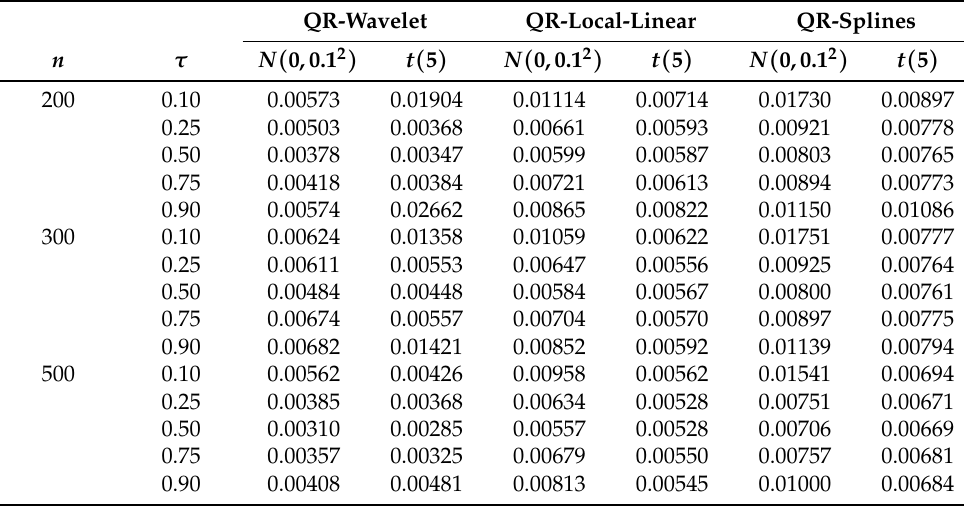
Table 2. MSEs of wavelet, local linear and spline smoothing in Case II: